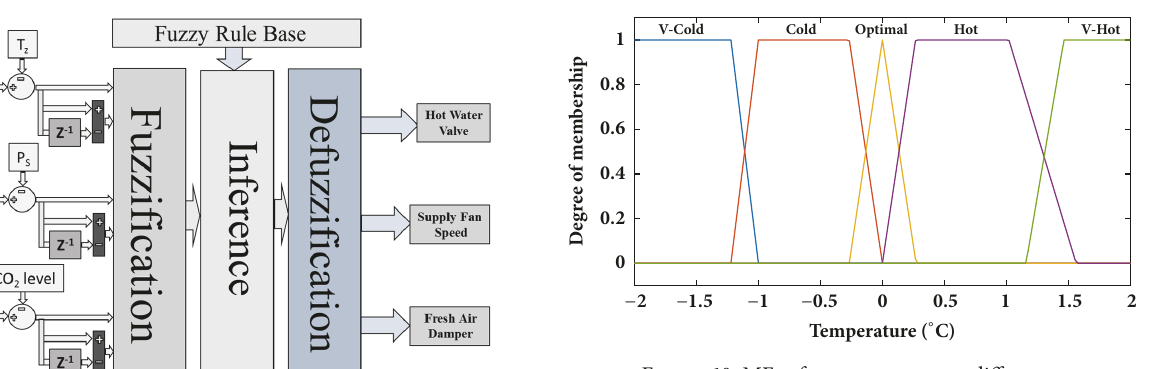
Figure 10: MFs of zone temperature